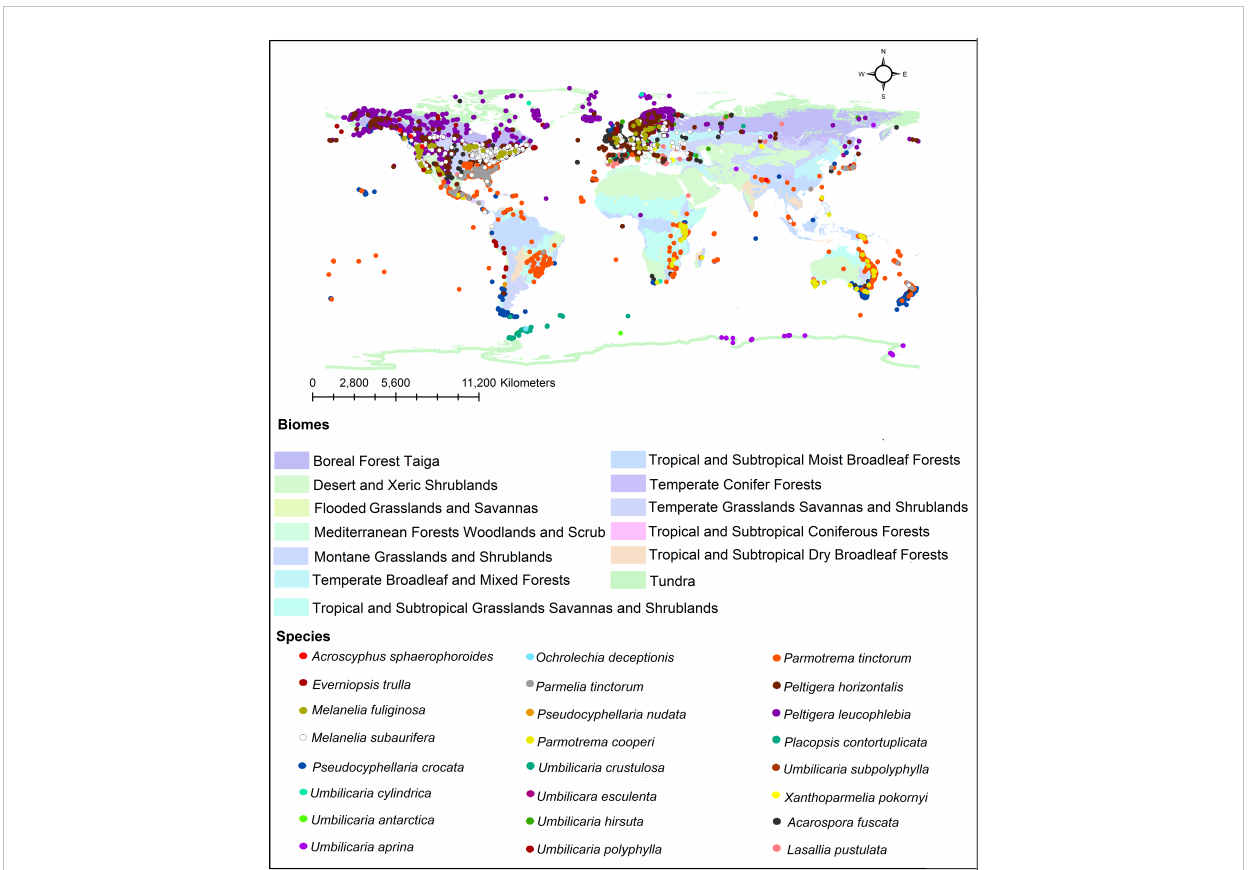
FIGURE 5 Global distribution of tridepside-containing lichen species based on the occurrence data from ALA, GBIF, BioCollecions, iNaturalists, and BISON